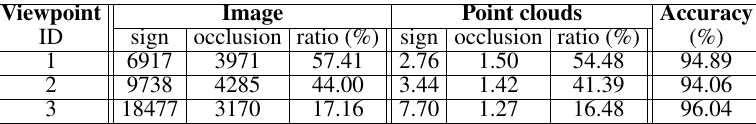
Table 2. The occlusion ratio accuracy calculation result of viewpoints in Fig. 2.